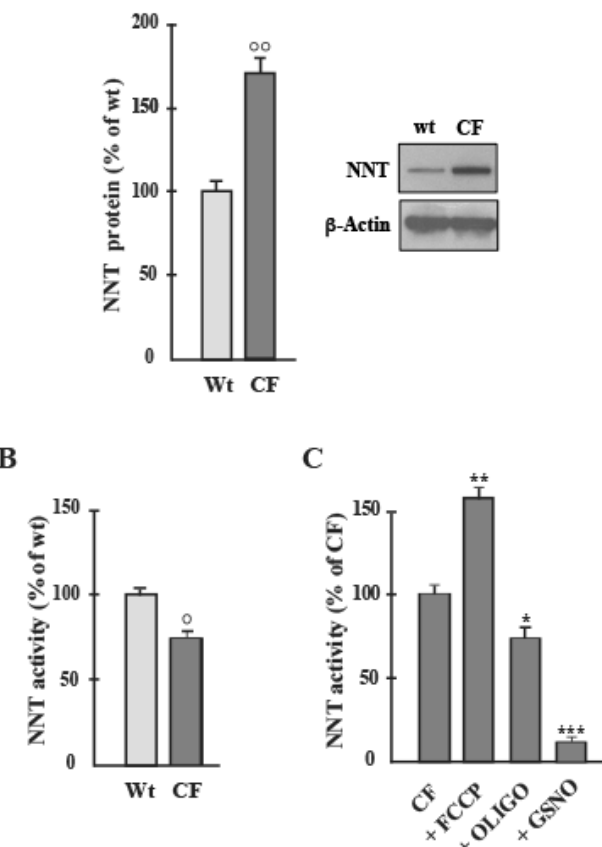
Figure 1. NNT protein level and activity in airway cells. ( A ) NNT protein expression in Wt and CF cells was detected by Western blot analyses. The blot incubated for each antibody was stripped and reprobed with anti ß ‐ actin antibody. Protein amount was expressed, after normalization with respect to corresponding β‐ actin, as a percentage of the content inWt cells to which a value of 100 was CCCP (3 μ mol/L), OLIGO (1.5 ng/ml) and GSNO (1 mmol/L) were added 15 min before activity determination. Values were subjected to statistical analysis (Wt, n = 4; CF, n = 5): ( B ), ° p < 0.05 when comparing CF with the Wt ‐ samples); ( C ), * p < 0.05, ** p < 0.01 , *** p < 0.001 when comparing untreated cells with the cells in the presence of compounds).